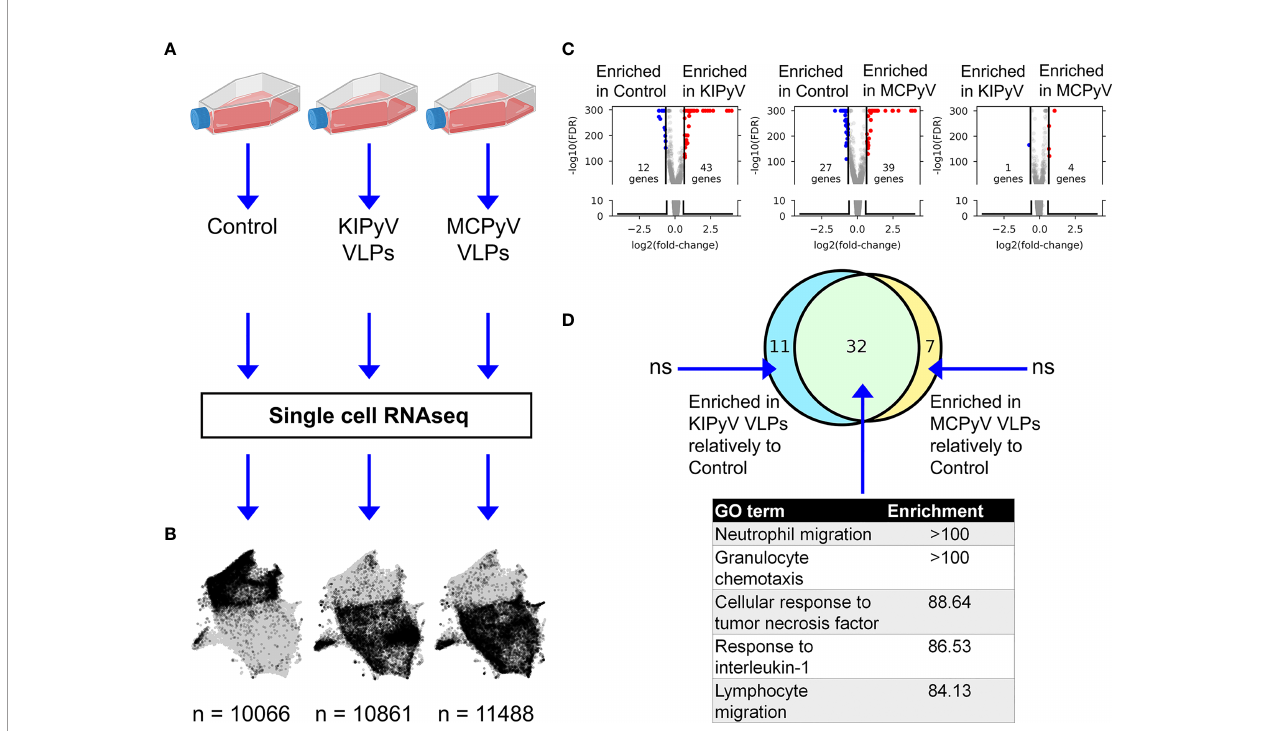
FIGURE 8 | ScRNAseq gene expression pro fi ling of THP-1 macrophages stimulated with PyV-derived VLPs. (A) Experiment outline. (B) UMAP representation of scRNAseq data. Gray dots denote cells from all conditions combined. Black dots highlight cells from a given condition. Numbers at the bottom indicate the number of single-cell transcriptomes post- fi ltering. The conventional mitochondrial count fi lter (to remove dead cells) was intentionally omitted to enable the estimation of the fraction of dead cells. (C) Volcano plots showing bulk-like differential genes expression analysis results. Differentially expressed genes (DEGs) were de fi ned as having an absolute fold change > 1.5 and FDR < 0.05 (Mann – Whitney U test). (D) Top: Venn diagram showing the overlap between sets of genes enriched in KIPyV VLP- treated cells relatively to control, MCPyV VLP-treated cells relatively to control, and MCPyV VLP-treated cells relatively to KIPyV VLPs. Bottom: GO enrichment analysis results for each subset of genes shown in the Venn diagram. n.s., no signi fi cant GO term enrichment. Data information: To prepare (A) , https://biorender. com/was